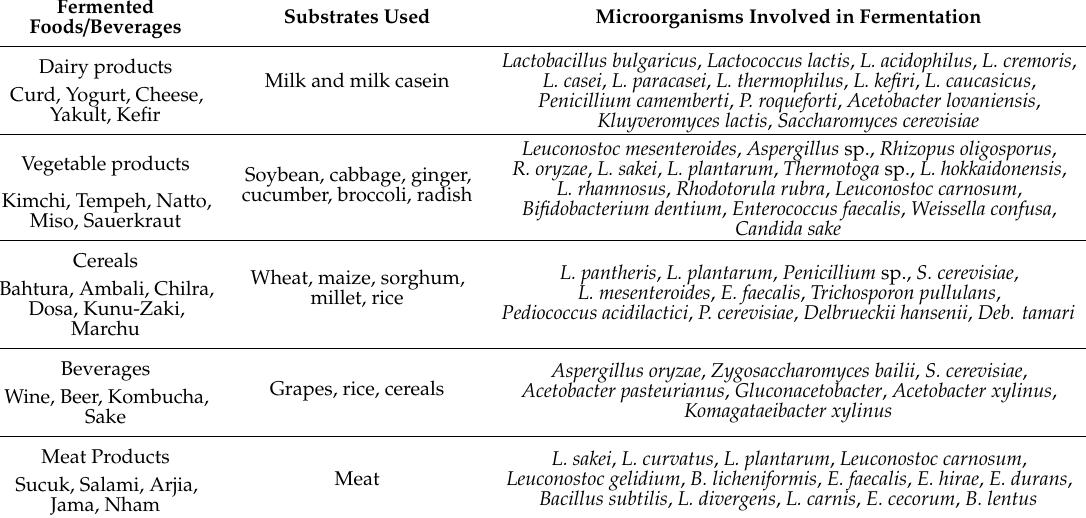
Table 1. Some of the most commonly prepared fermented foods / beverages with their fermenting